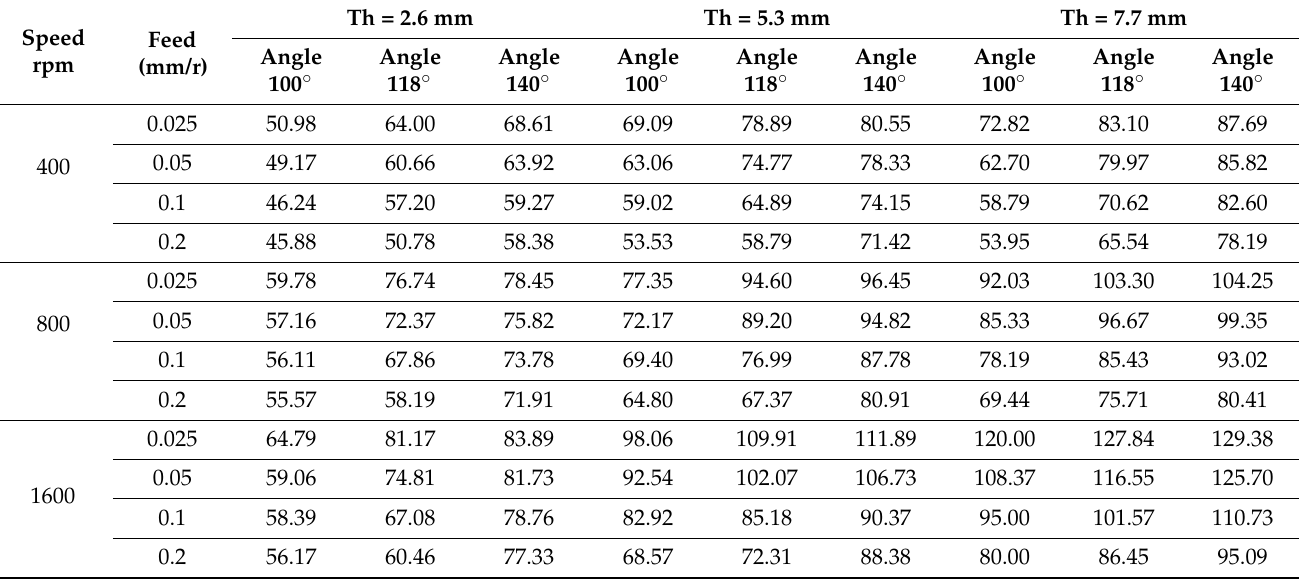
Table 6. The variation of HAZ with speed, feed, thickness, and point